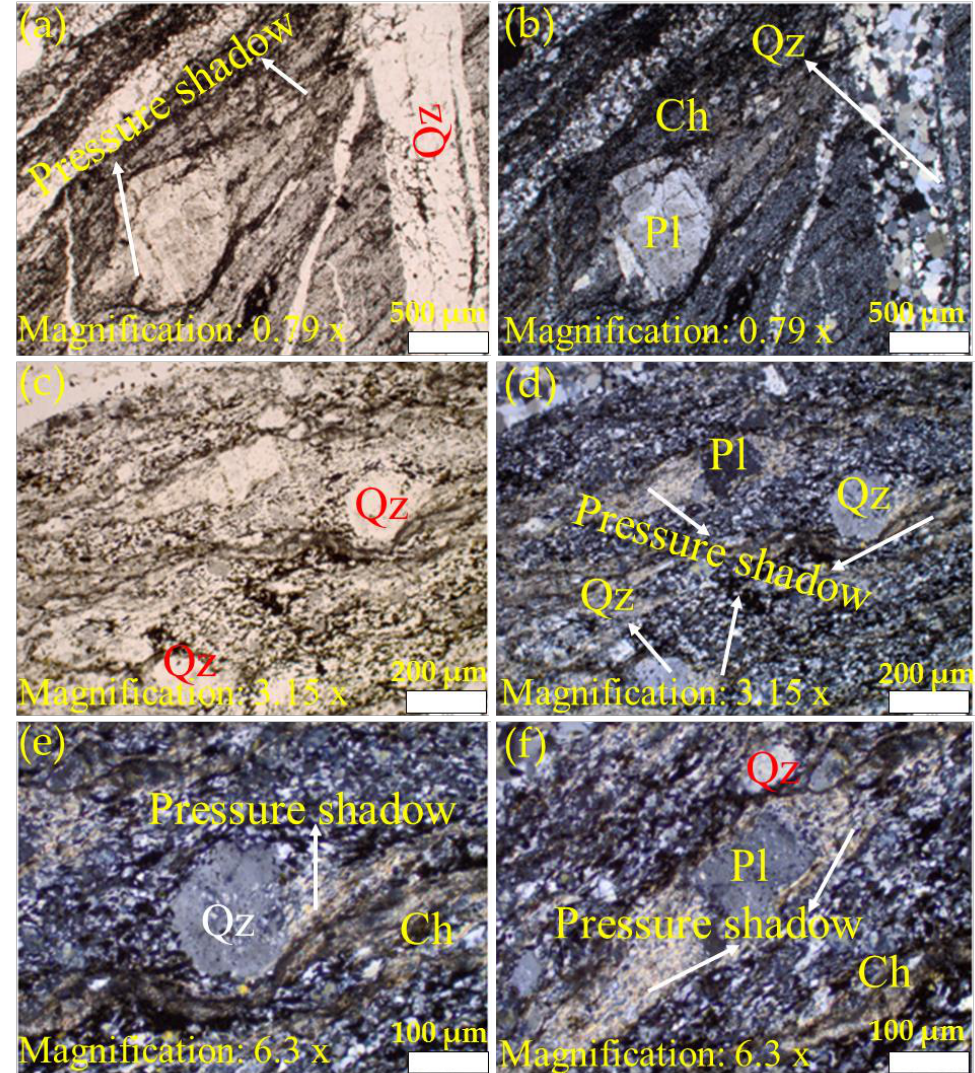
Figure 6. Images ( a – f ) were captured at different magnifications to reveal rock texture, mineral composition, and alterations in the meta-reworked crystal-rich felsic tuff. Images ( a , b ) display fine-grained unequigranular blastoporphyritic texture. Notice plagioclase and quartz (not visible in this image) blastophyres are set in a highly sheared and foliated microcrystalline felsic rock matrix. Images ( c , d ) illustrate that the rock is very highly deformed, mylonitized, and sheared. This is well demonstrated by rotation and the presence of pressure shadows in blastoporphyrites of plagioclase and quartz. Pressure shadows are marked by granulation of blastophyres and the presence of phyllosilicates (biotite/chlorite/sericite). Image ( e ) displays quartz blastoporphyrite granulation and pressure shadows occupied by phyllosilicates. Image ( f ) further illustrates distinct pressure shadows in plagioclase blastophyre, which is occupied by microcrystalline phyllosilicates. PPL: plane-polarized light; CPL: cross-polarized light.